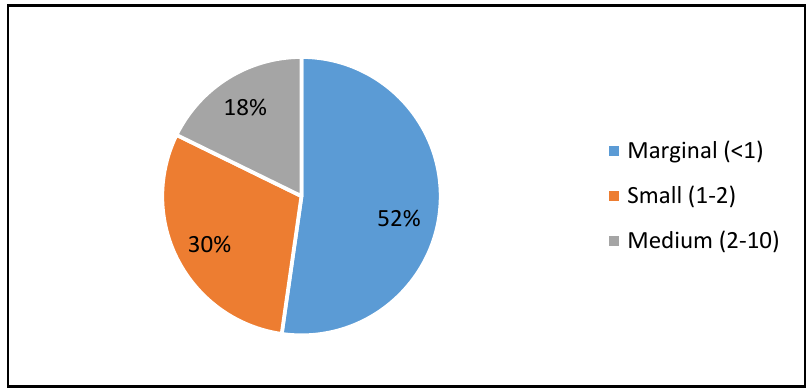
Figure 4. Sample farmer landholding.